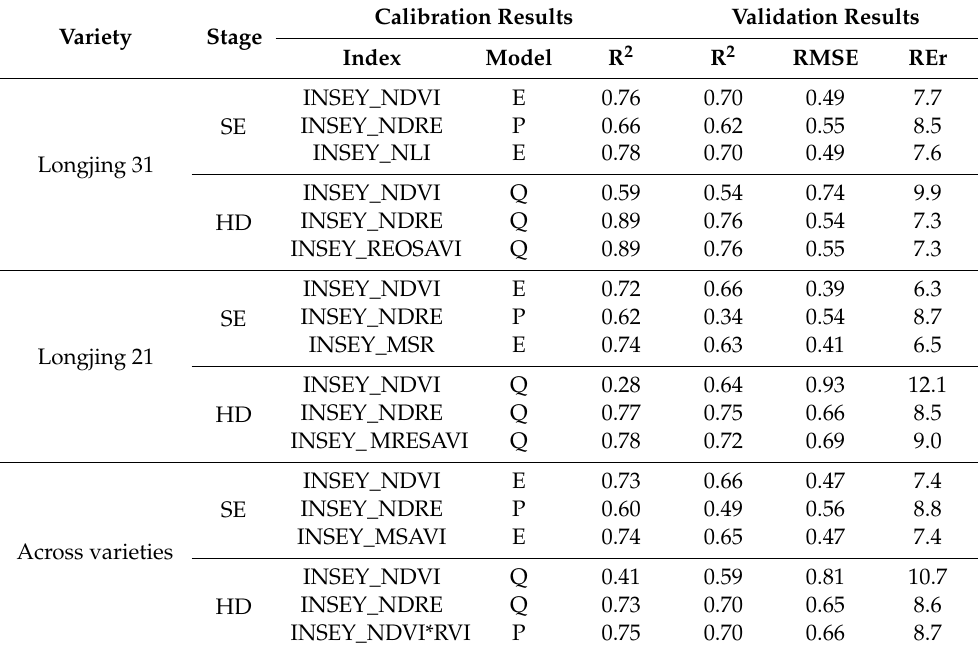
Table 4. Calibration and validation results for predicting yield without additional topdressing N application (YP 0 ) using the in-season estimate of yield (INSEY) calculated with the RapidSCAN’s default indices (NDVI and NDRE) and the best performing vegetation indices for two varieties at the stem elongation (SE) and heading (HD) stages in 2014–2016. Calibration